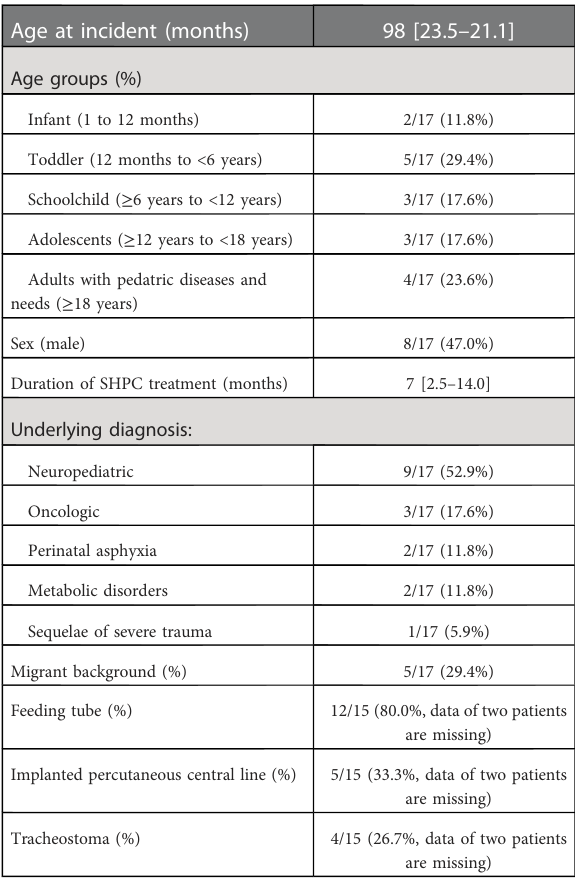
TABLE 1 General characteristics of the study population ( N